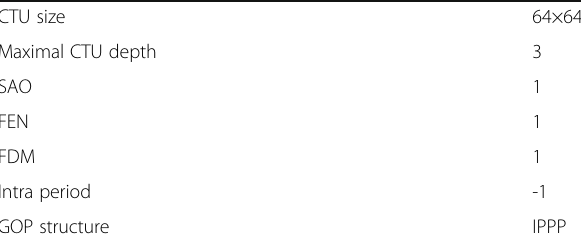
Table 3 Typical configuration of